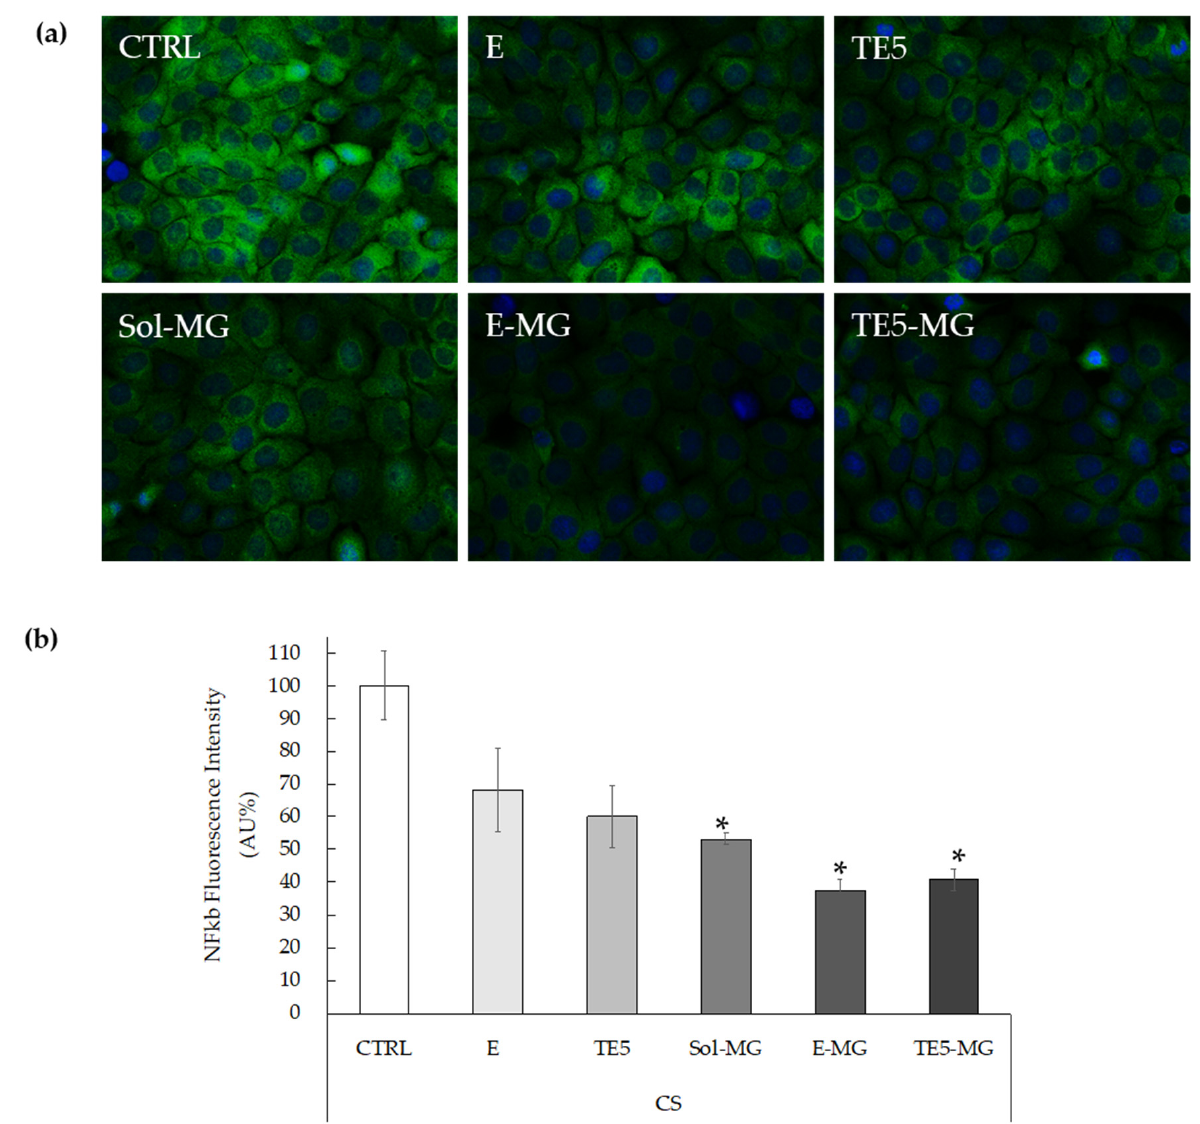
Figure 7. Representative images of immunofluorescence staining for NF-kB (green) and DAPI (blue) at 40× magnification on HaCaT cells treated with empty or MG-loaded vehicles and exposed to CS ( a ). Quantification of immunofluorescence staining of NF-kB 1h after CS exposure ( b ). Data were normalized with respect to the CTRL sample and expressed as arbitrary units ± SD. * p < 0.05 vs. CTRL sample by ANOVA.